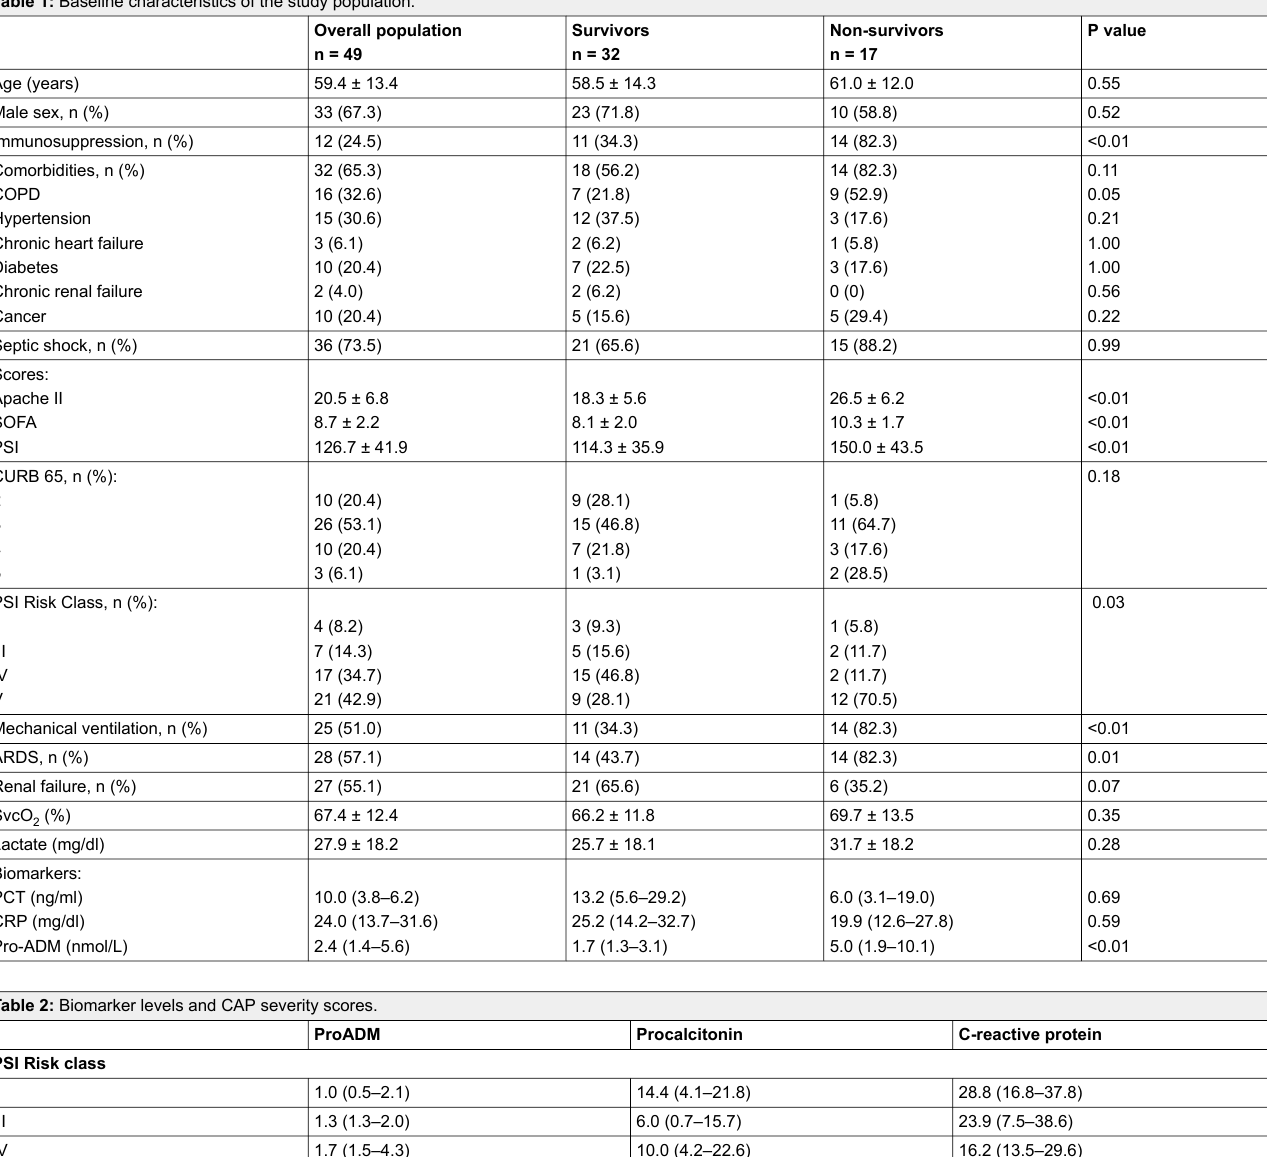
Table 1: Baseline characteristics of the study population.